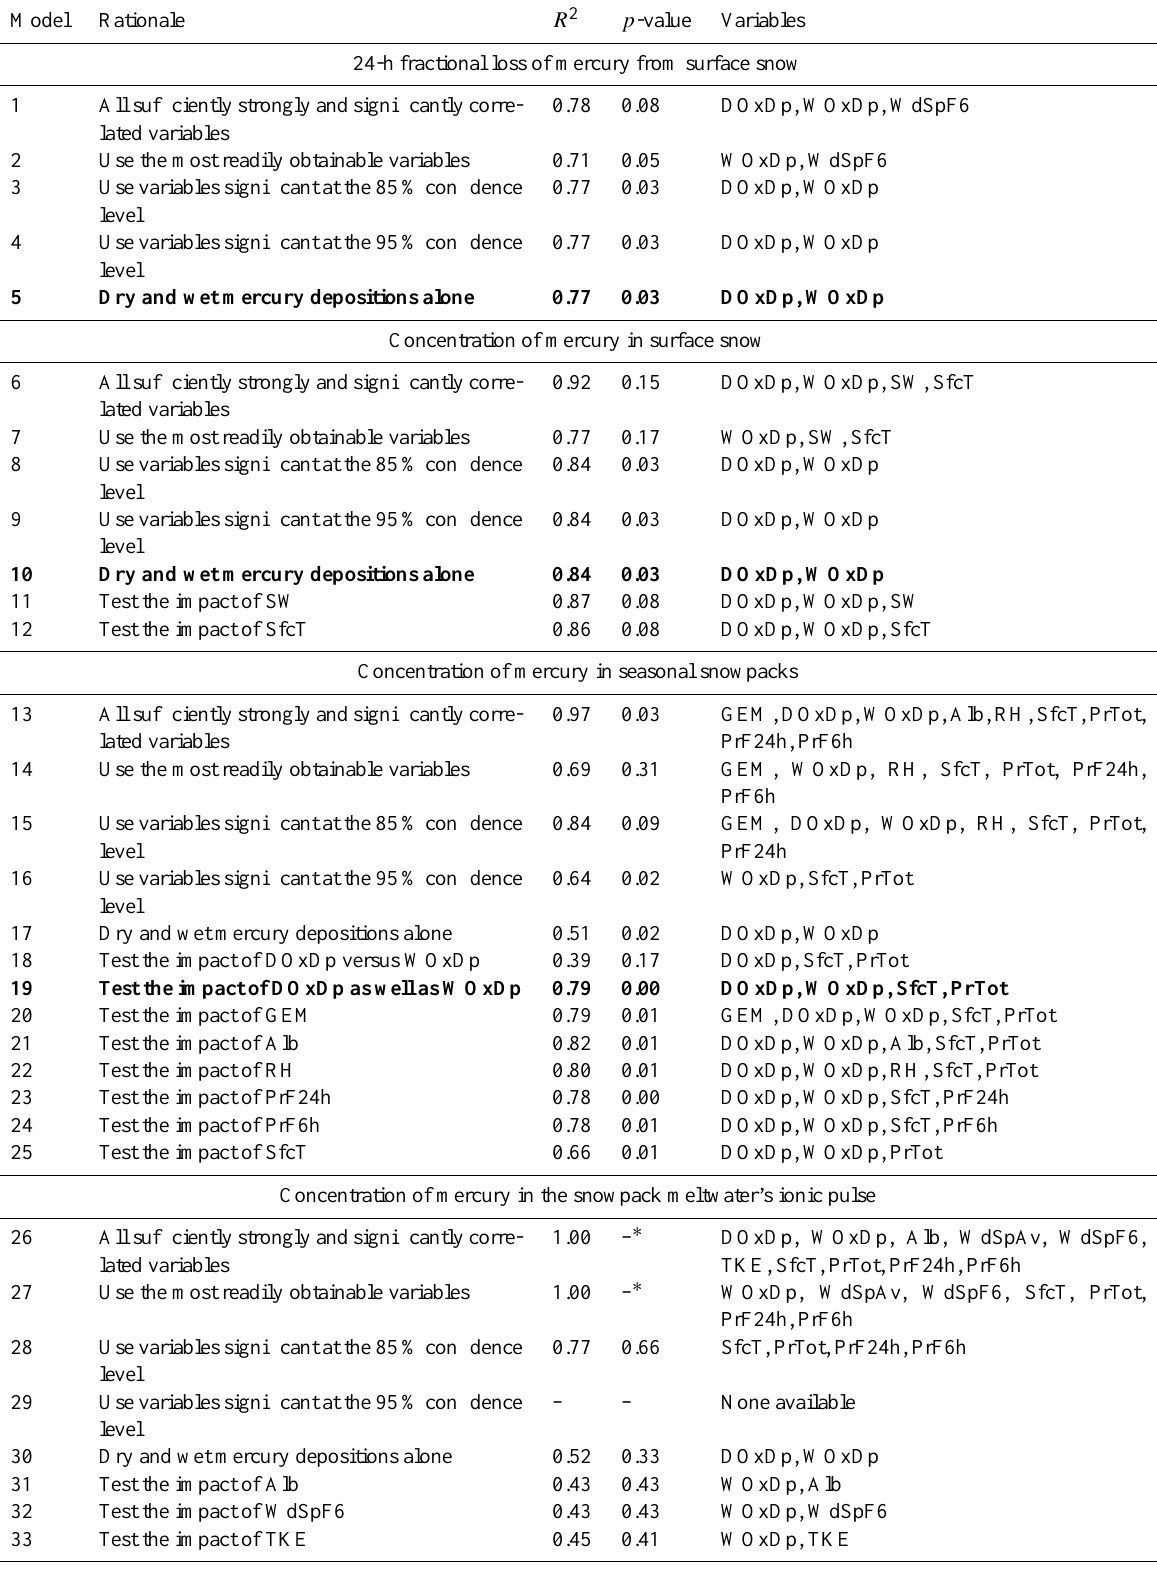
Table 12. Multiple linear regression models for Set2. Bold font indicates the best model for each mercury observation